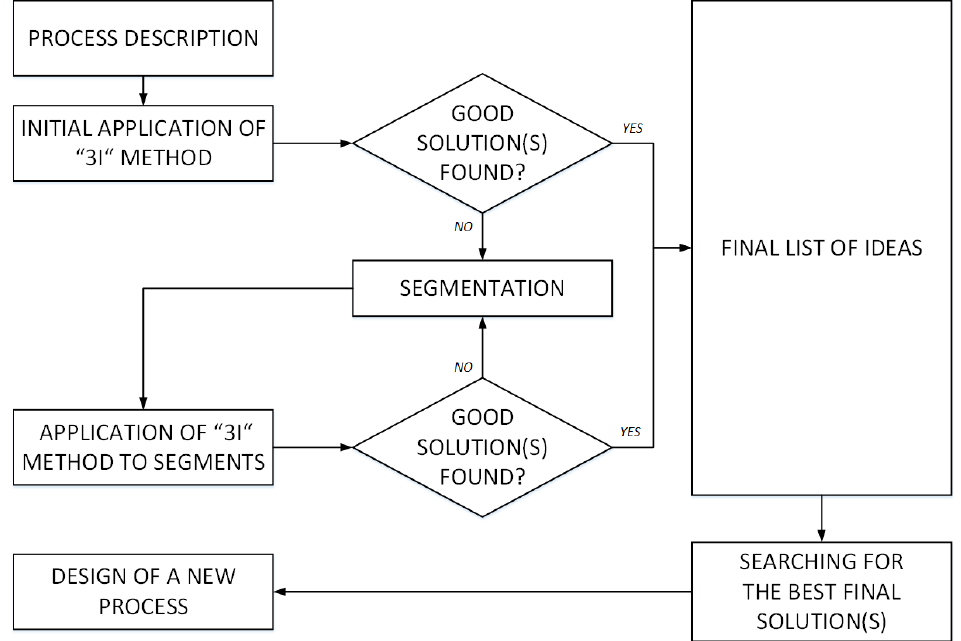
Figure 1. A scheme of the Algorithm for Process Innovation by Increasing Ideality.